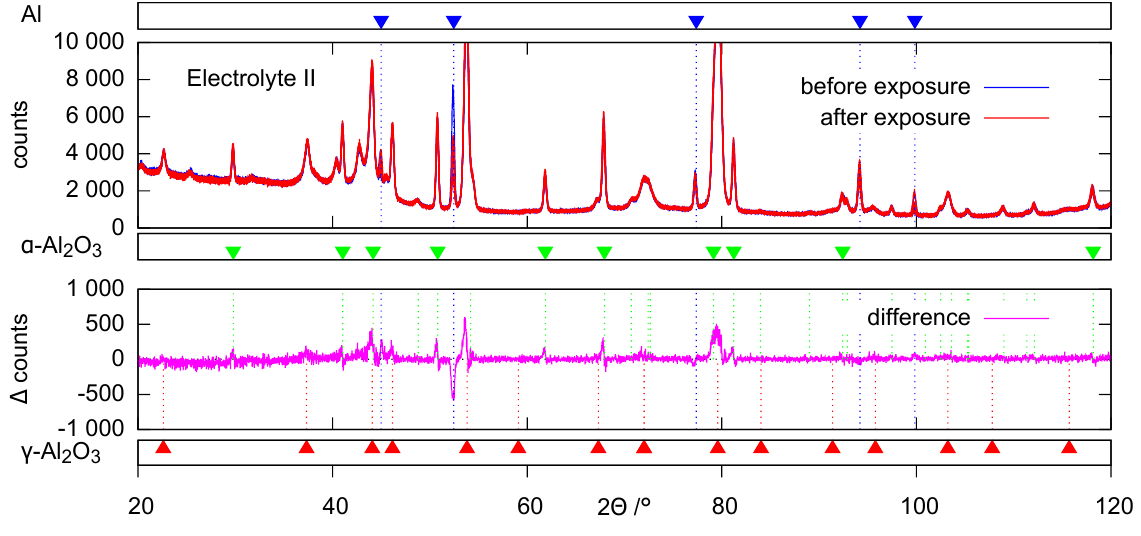
Figure 7. XRD diffractograms of the five PEO-coated samples exposed to electrolyte II before (blue) and after (red) the exposition experiments as well as the average difference graph (purple).